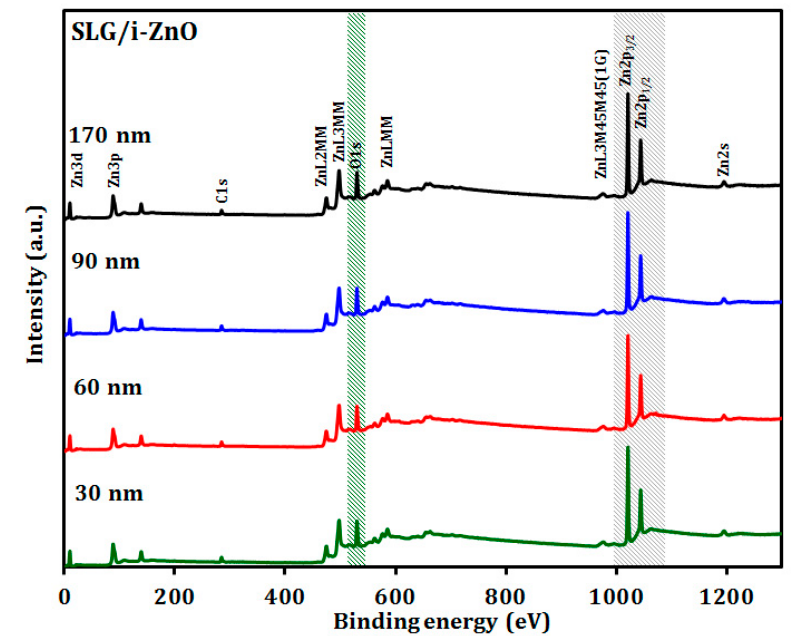
Figure 7. XPS survey spectra of the SLG/i-ZnO thin films with different thicknesses.